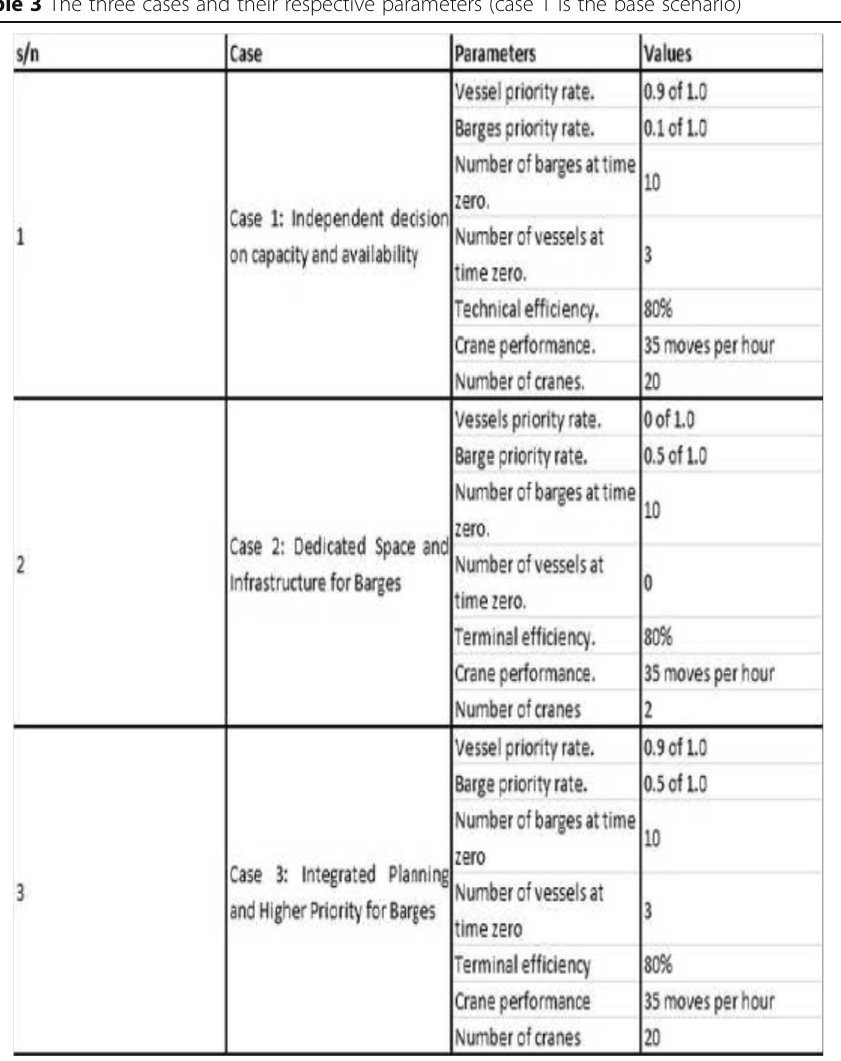
Table 3 The three cases and their respective parameters (case 1 is the base